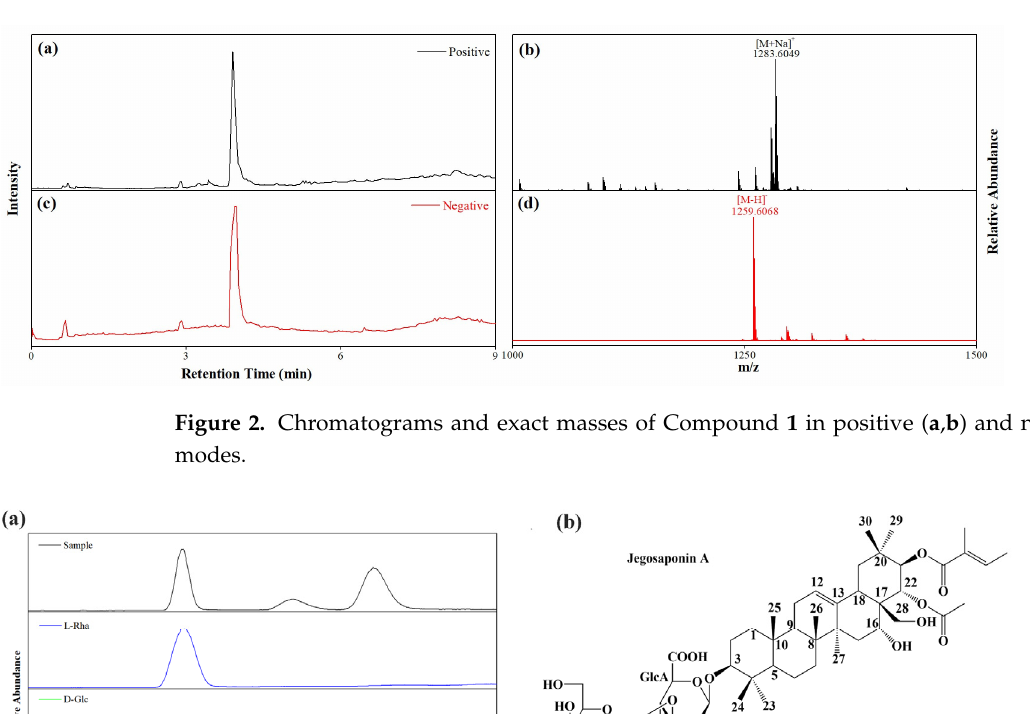
Figure 1. Antinociceptive effects of fractions of EAE3 in antinociceptive tests. 10 mg/kg of fractions from EAE3 in the writhing test ( a ) and the formalin test ( b ). Vehicle: blank control, INDO: indo- methacin, MOH: morphine hydrochloride. Data are displayed as mean ± SD, *** p < 0.001 vs. vehicle group.